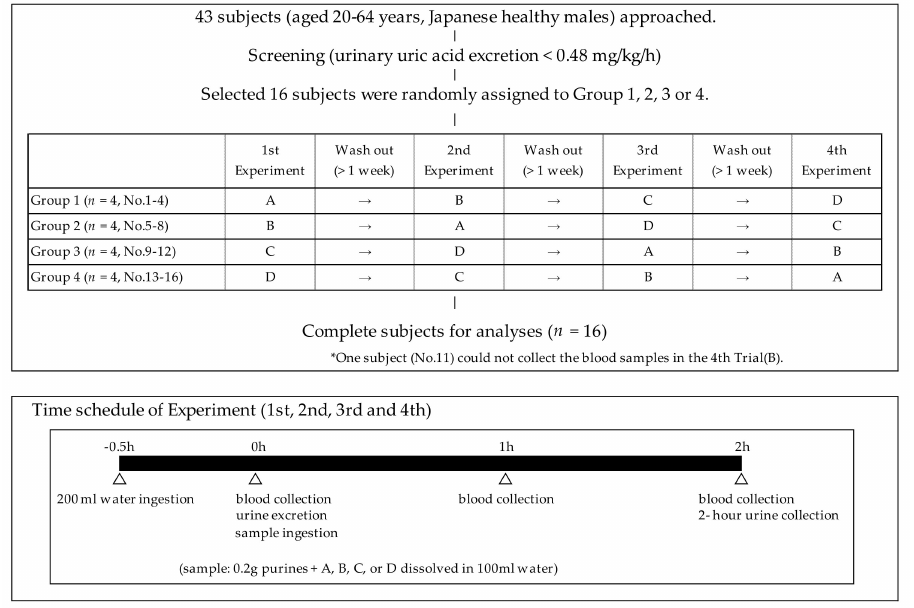
Figure 1. Study schedule showing the randomized, single-blind, placebo-controlled, crossover study